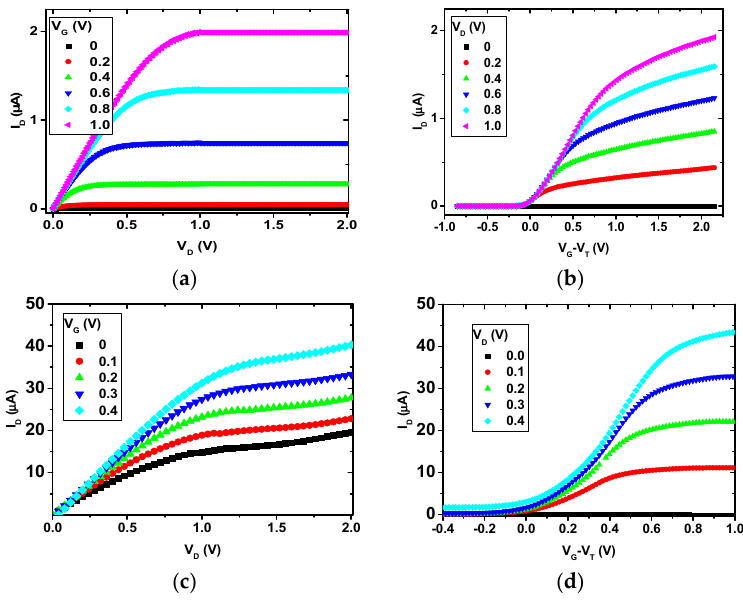
Figure 8. Output and transfer characteristics of nMOSFETS without dislocations ( a , b ) and with a dislocation network ( c , d ). The device layer thickness was 80 nm. The channel length and width, respectively, for both devices are 1 μ m. Caused by the different threshold voltages (V T ) of both devices, the gate voltage (V G ) is represented for clarity as V G –V T .